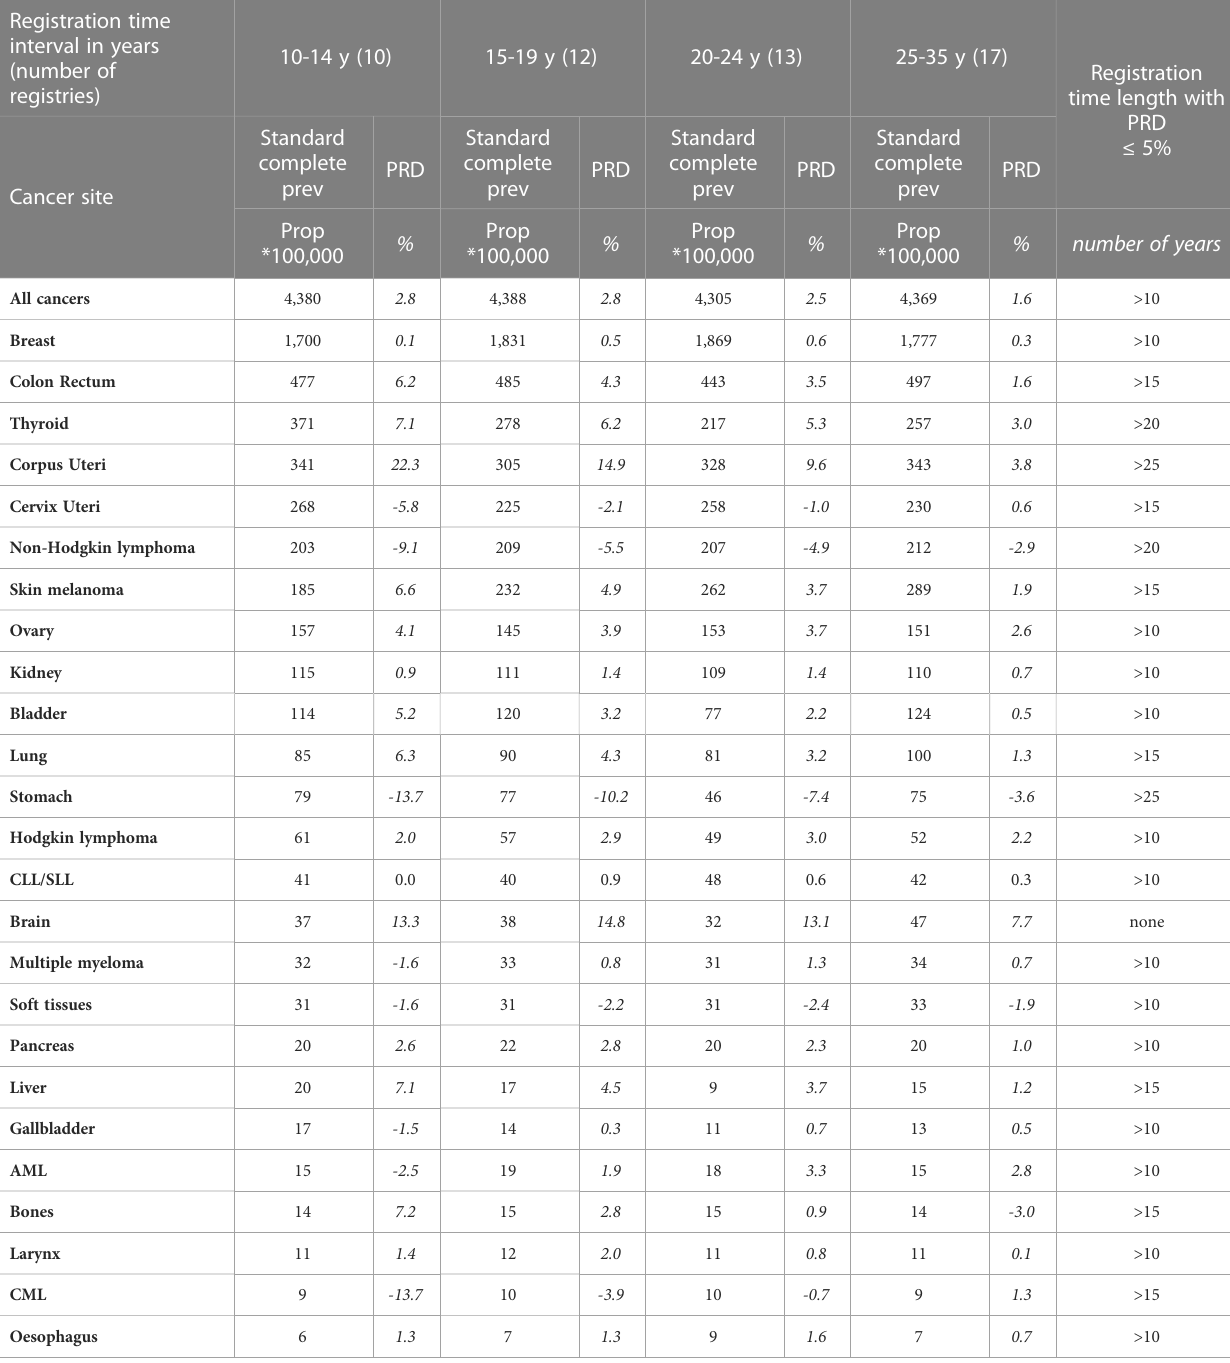
TABLE 4B Comparison between SEER and standard model-based complete prevalence at 1/1/2013 by cancer site for the 62 European registries included in the study grouped by registration time length (from 10-14 years to 25-35 years),